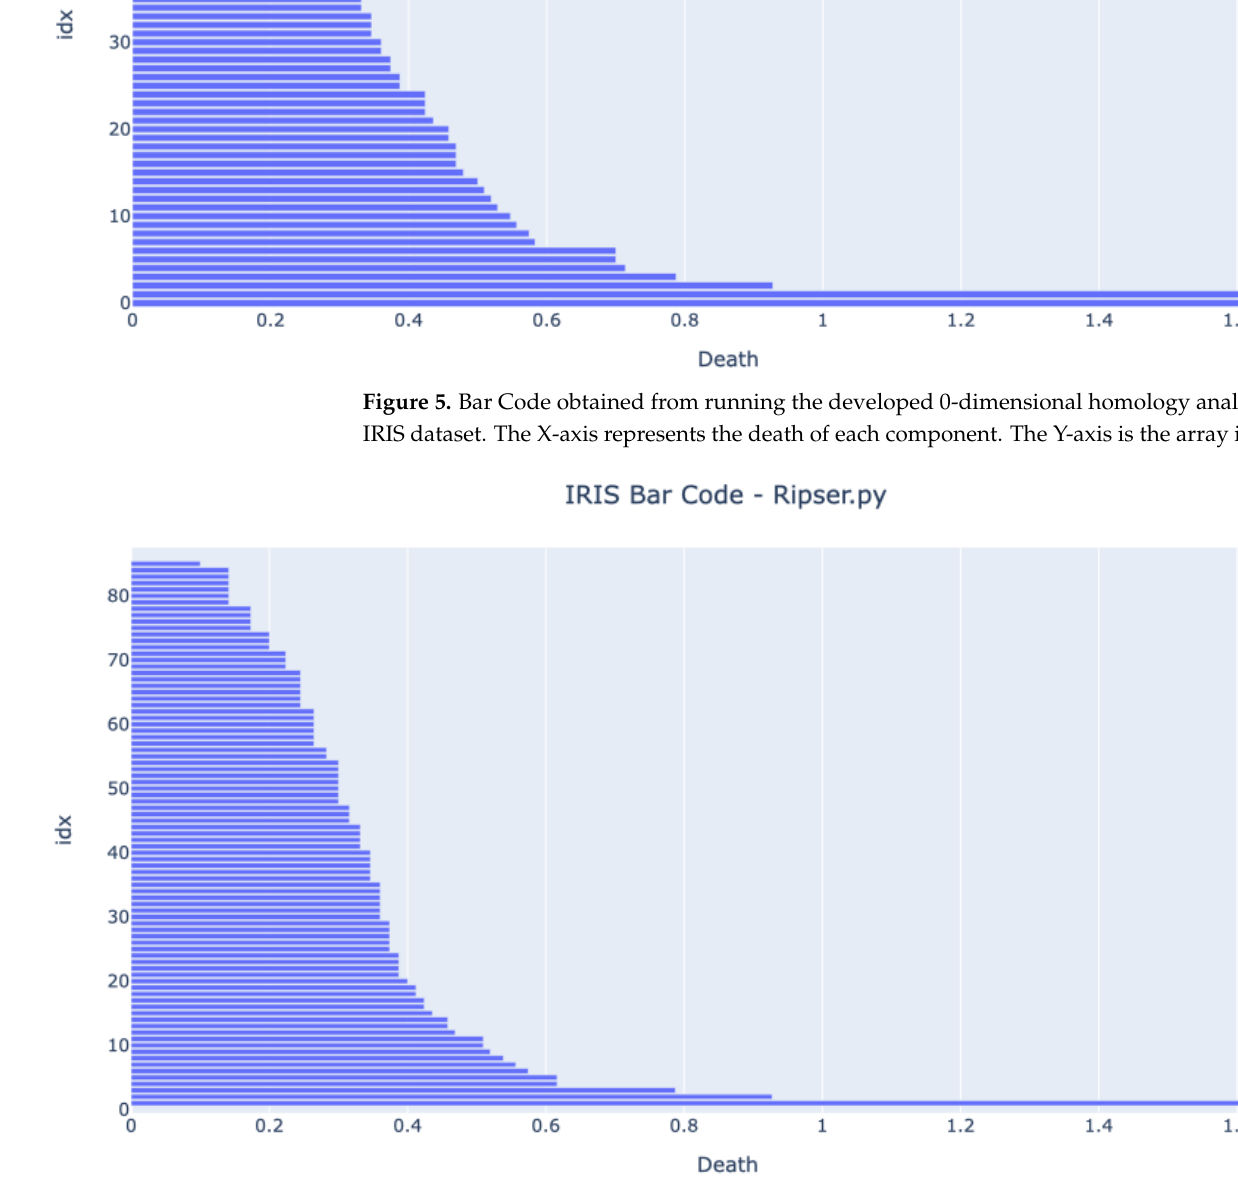
Figure 6. Bar Code obtained from running the scikit-tda ripser 0-dimensional homology analysis on the IRIS dataset. The X-axis represents the death of each component. The Y-axis is the array index. The barcodes are similar, meaning that the developed method provides the same results as other proven methods. The figures show that the expected bar code behavior happens once the three bars that live longer than any other represent the four